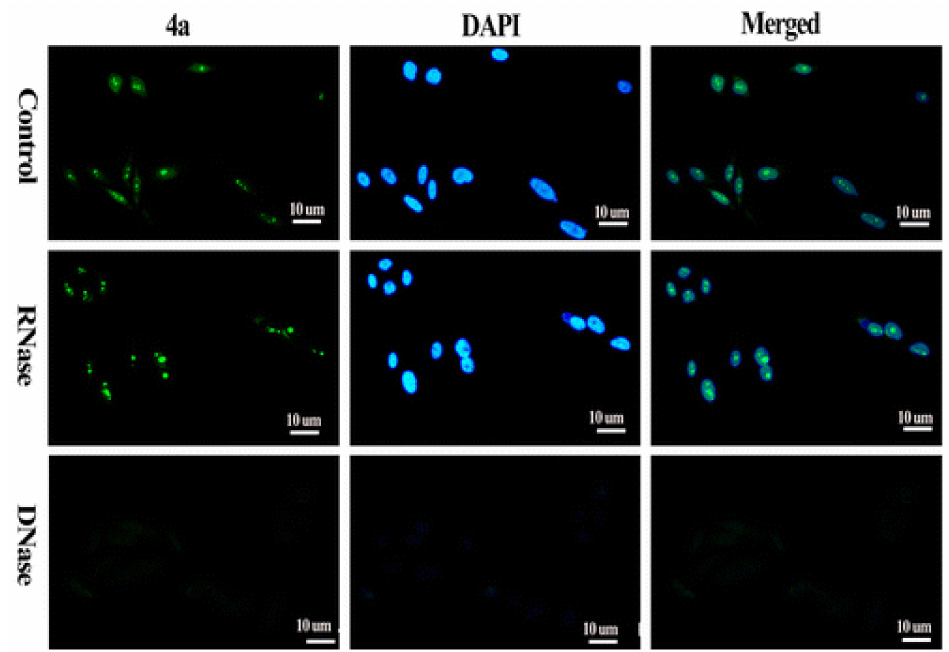
Figure 5. The compound 4a is p-(dimethylamino)styryl substituted TO. Fluorescence micros-copy of PC3 cells shows that the probe 4a enters the nucleus and foci correspond to rDNA of nucleoli